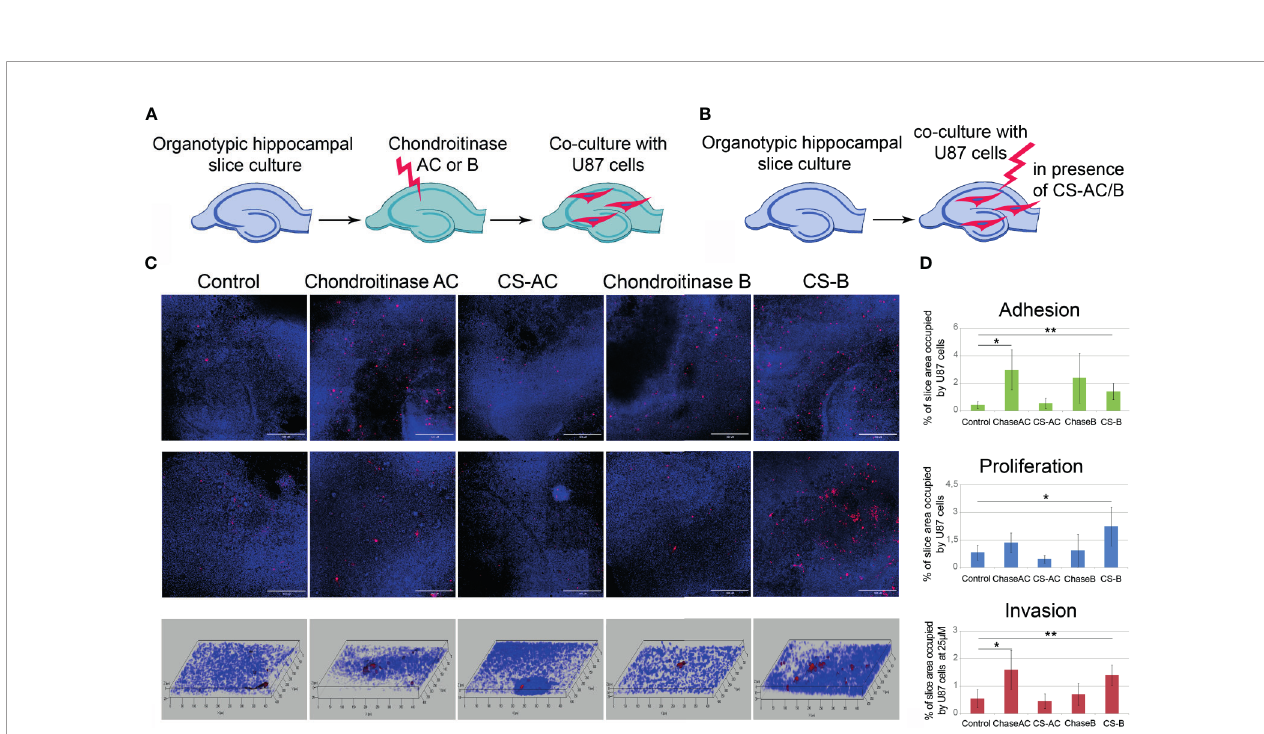
FIGURE 7 | Effects of experimental modulation of CS content on adhesion, proliferation and invasion of GBM cells ex vivo . (A, B) Schemes of the experiment. (C) Confocal microscopy of U87-RFP cells seeded on the control organotypic brain slices and slices treated with chondroitinase AC or exogenous chondroitin sulfate AC (CSAC), chondroitinase B or chondroitin sulfate B (CSB). Cells nuclei are stained with DAPI. Scale bar 500 µm. (D) Quantitative analysis of the U87-RFP cells on the control and treated rat brain tissues (ImageJ 1.52 software). ANOVA and post-hoc Fisher ’ s LSD test, *p < 0.05, **p < 0.01. TMZ, temozolomide; DXM, dexamethasone.